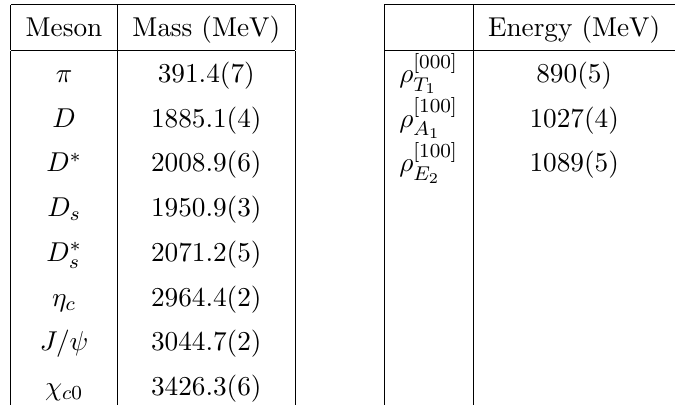
Table 2 . Ground state masses of stable mesons (left) and the energy of the lowest-lying (cid:12)nite- volume energy level for lattice irrep (cid:3) and momentum relevant for the (cid:26) meson denoted by (cid:26) ~p (right) as measured on our ensemble [18, 19, 52, 57]. Only the statistical uncertainty is quoted.